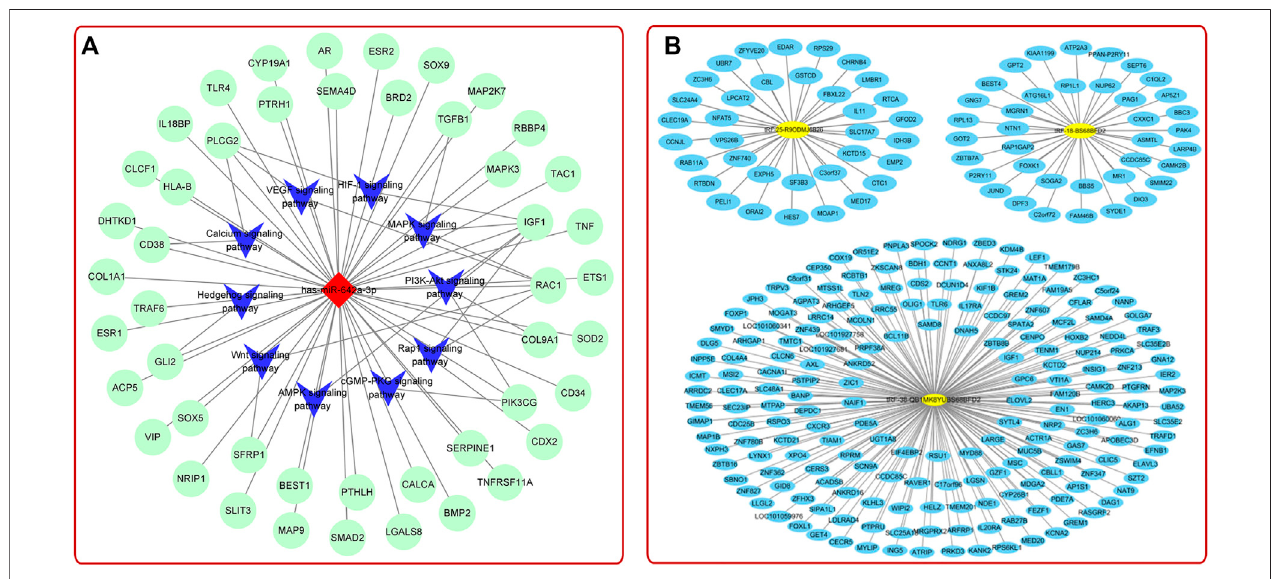
FIGURE 6 | (A) MiRNA-mRNA-KEGG interaction network analysis showed the top 10 OP-related pathways (Kong et al., 2021). (B) TRF-25, tRF-38, and tRF-18 were potential targets to OP treatment (Zhang Y. et al.,